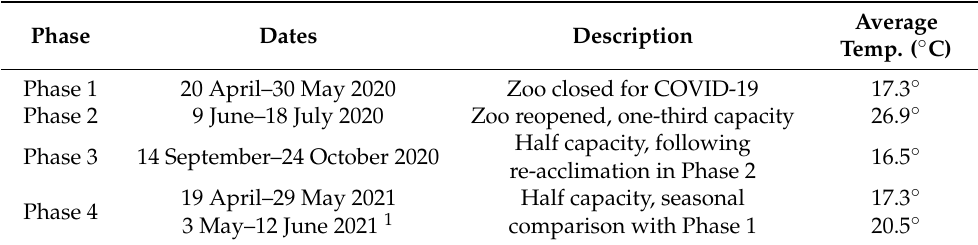
Table 1. Space use data were collected during four six-week phases.